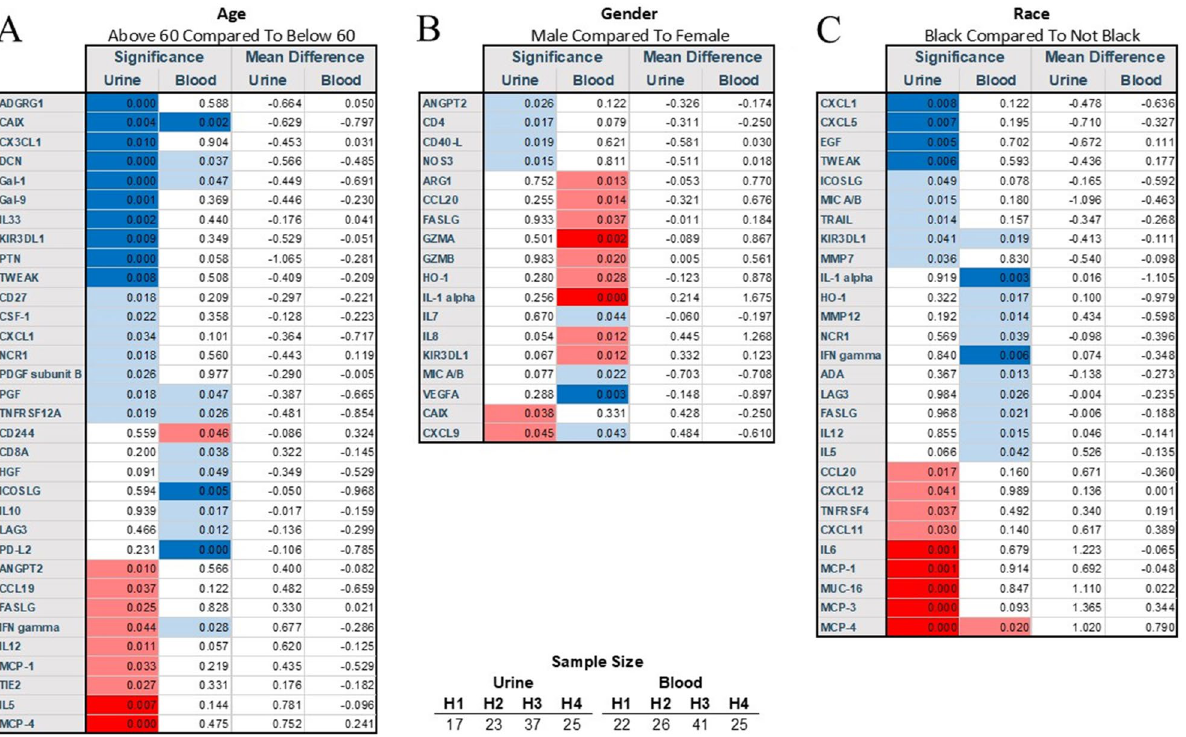
Figure 2. Demographic variables include age ( A ), gender ( B ), and self-declared race ( C ) affected the immunological profile in COVID-19